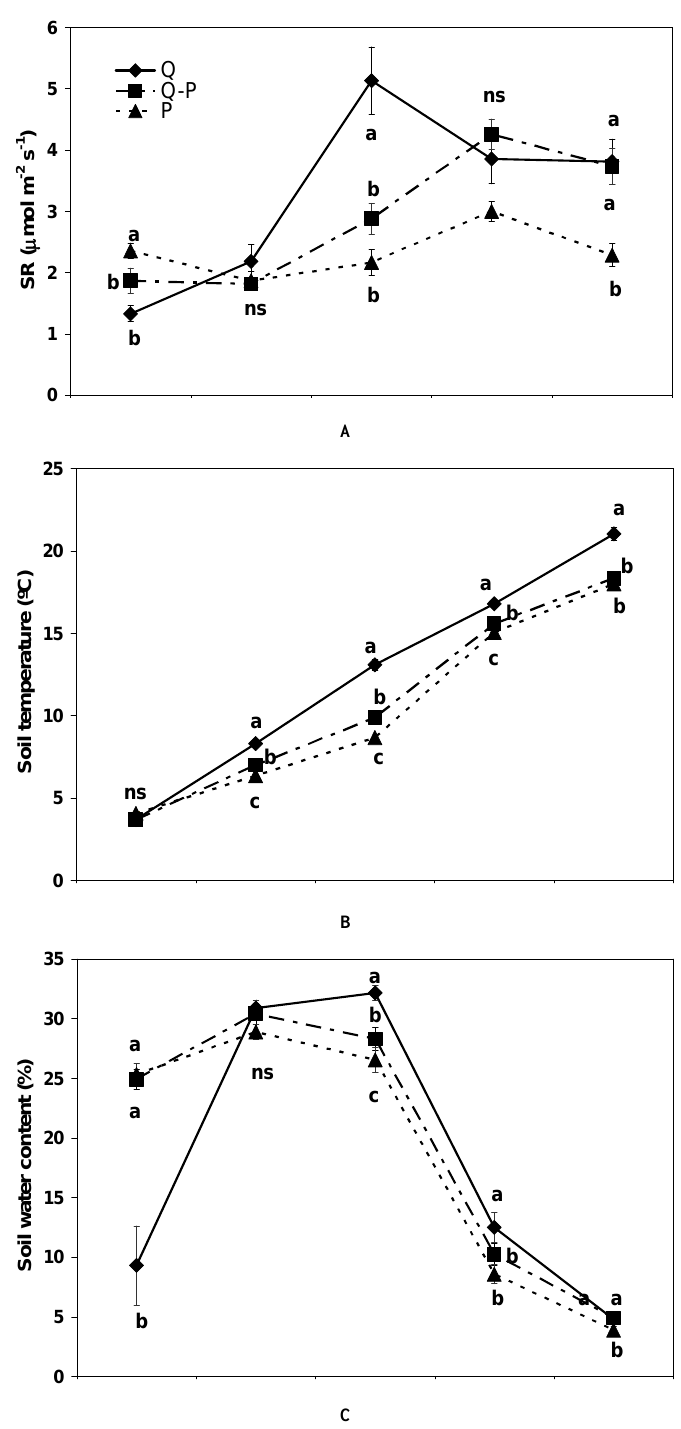
FIGURE 1 . Seasonal variation of (A) soil respiration, (B) soil temperature, (C) soil moisture, and (D) monthly precipitation in the stands: P ( P. sylvestris L), Q ( Q. pyrenaica Lam), Q-P ( Quercus-Pinus ) from February 2006 to July 2006 (no data are available for January when snow covered the ground or in April). Each value represents the mean of 20 measurements at each stand; bars indicate ± SE. Different letters indicate significant differences between stands at p < 0.05; ns = not